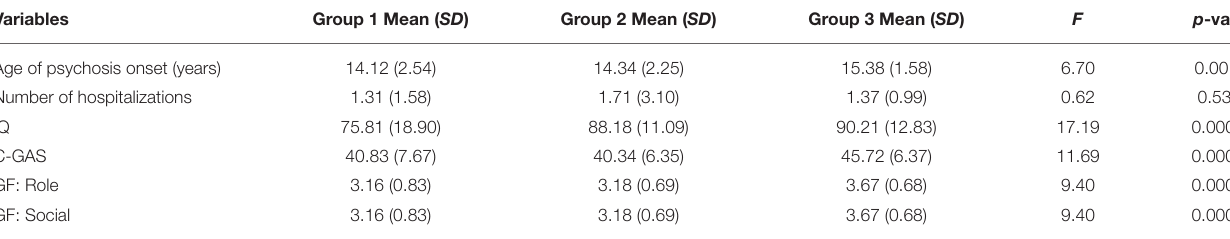
TABLE 3 | Group differences on age of psychotic onset, number of hospitalizations, IQ, and functioning.